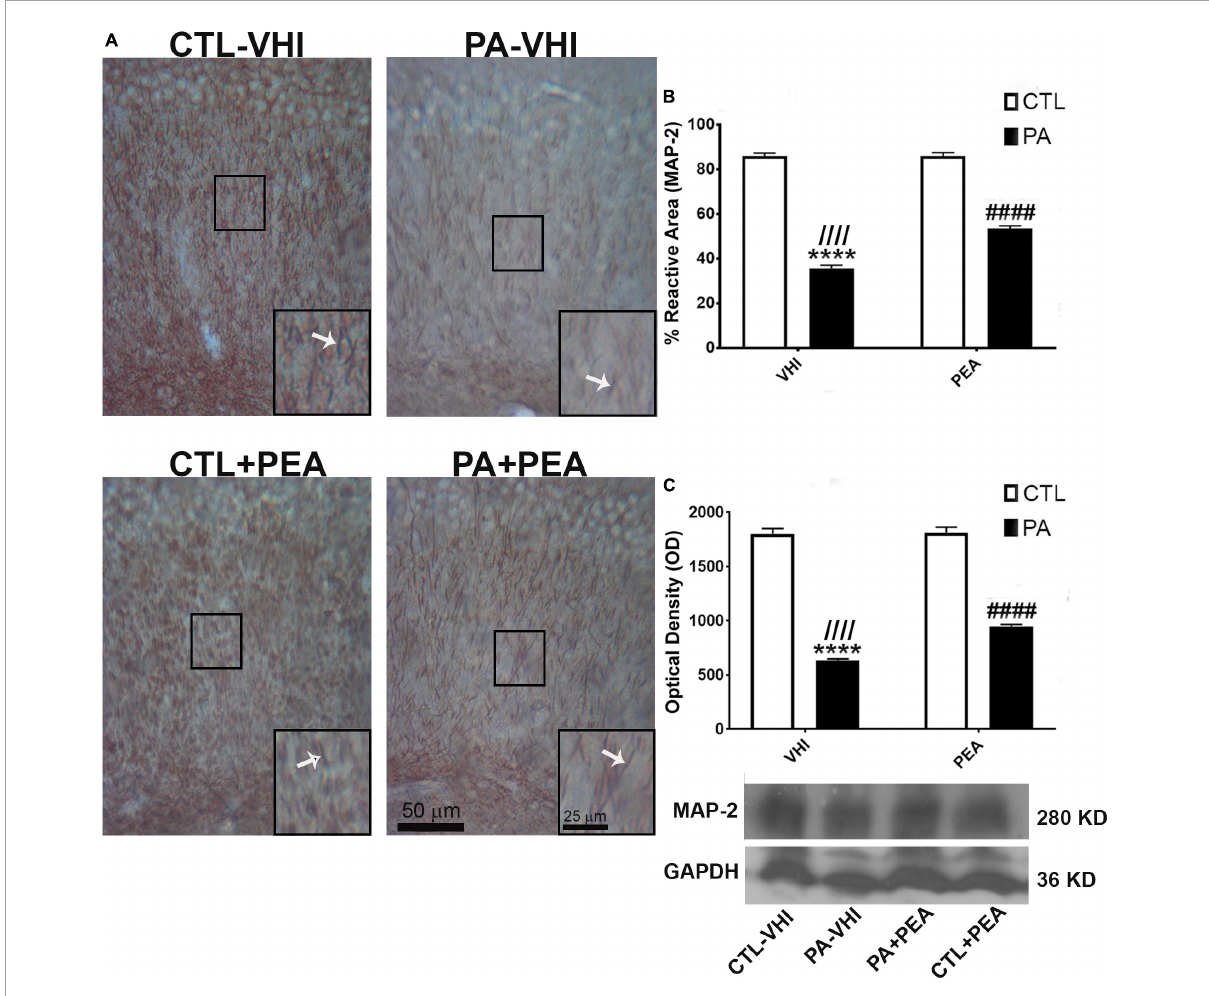
FIGURE7 Microtubule-associated protein (MAP-2) immunostaining and protein expression in the rat hippocampus on P21. (A) Representative images of the stratum radiatum of CA1 hippocampal area immunostained for MAP-2. Scale bar: 50 µ m. Marked rectangular areas in the main-image are shown magnified in the corresponding lower right margin. The white arrow indicates positive immunostaining for MAP-2. Scale bar: 25 µ m. (B) Percentage of reactive area of MAP-2 positive dendrites. (C) Optical density of bands showing MAP-2 protein expression in Western blot. Results are shown as mean ± SEM. **** p < 0.0001, PA-VHI vs. CTL-VHI; //// p < 0.0001, PA-VHI vs. PA + PEA; #### p < 0.0001, PA + PEA vs. CTL-VHI. CTL-VHI, control rats treated with vehicle; PA-VHI, rats subjected to PA and treated with vehicle; PA + PEA, rats subjected to PA and treated with PEA; CTL + PEA, control rats treated with